Question: Give a one-sentence summary of this figure.
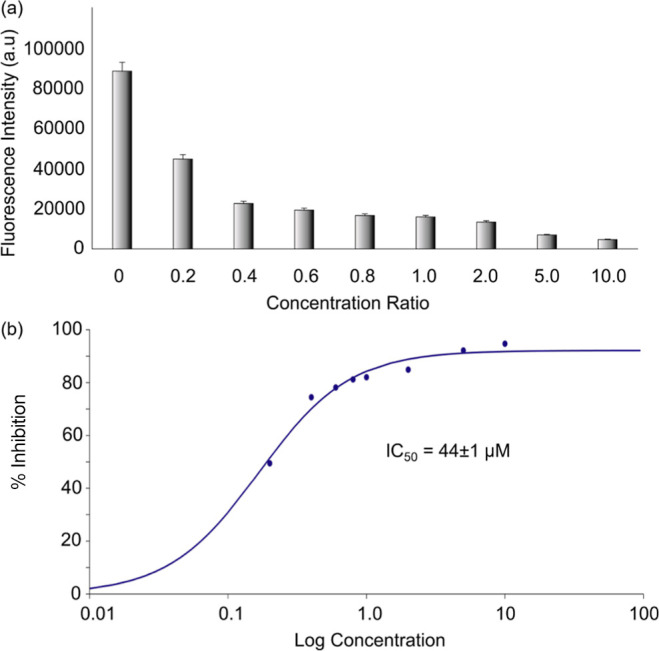
Answer: Figure . (a) Charts of fluorescence aggregation intensities at different concentrations of MR-8S with αA66–80-Crystallin peptide. (b) Percent inhibition of αA66–80-Crystallin peptide aggregates in increasing concentrations of MR-8S in 10 mM Tris buffer. All experiments were done in triplicate.